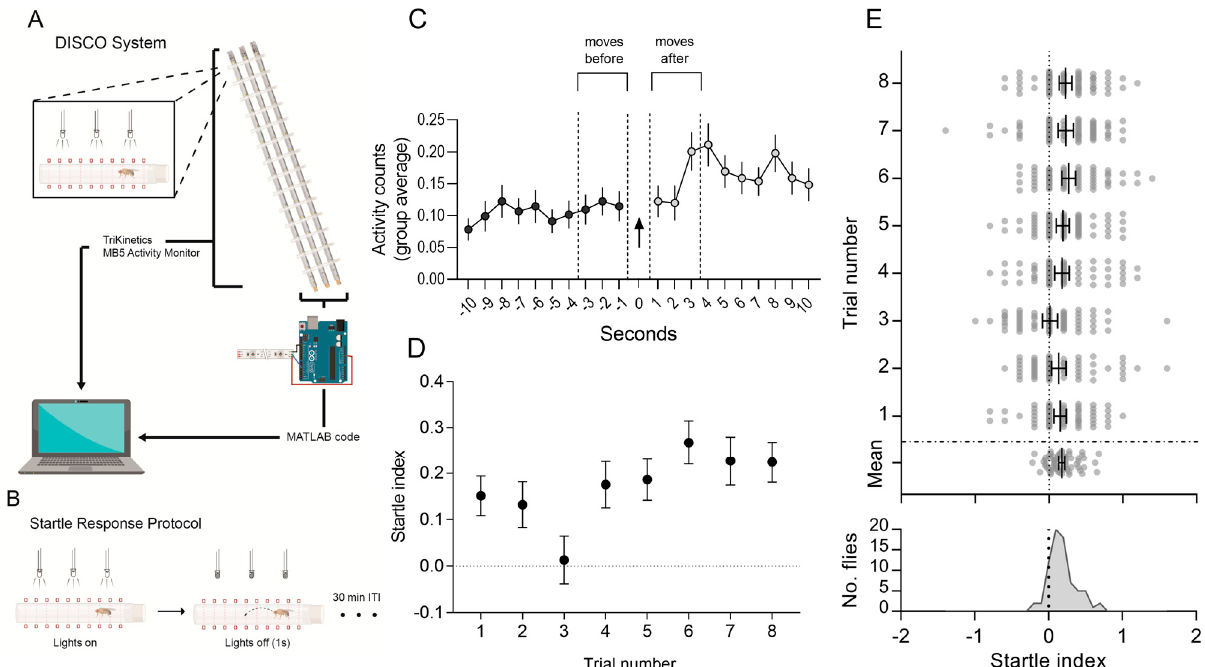
Figure 1. Automated detection of visually evoked motor response. ( A ). Schematics of the Drosophila Interactive System for Optical manipulations (DISCO). The system combines infrared movement detection and automatically controlled LEDs (figure adapted from [30]). ( B ). Each glass tube is aligned with three LEDs, which are turned off for 1 s to induce a visually evoked motor response, with a 30 min inter-trial interval (ITI) ( C ). The startle index was calculated considering the average movement counts of each fly three seconds before and after the lights-off stimuli presentation, represented by the arrow at t = 0 (figure adapted from [30]). ( D ). Flies were tested over eight trials consecutive trials, where group averages indicate an increased motor response for most stimuli presentation. Null startle indexes (dotted lines) denote measurements with no movement change. ( E ). Visualization of single fly responses across each trial indicated a highly variable individual behavior; however, the mean response for all trials (under the dashed line) shows a robust group effect ( p = 0.0004, n = 74 male and female flies, one-sample t-test against 0). Histogram of the flies’ mean startle values show no significant departure from a normally distributed response ( p = 0.052, D’Agostino and Pearson normality test). All central lines and bars represent mean ± SEM.